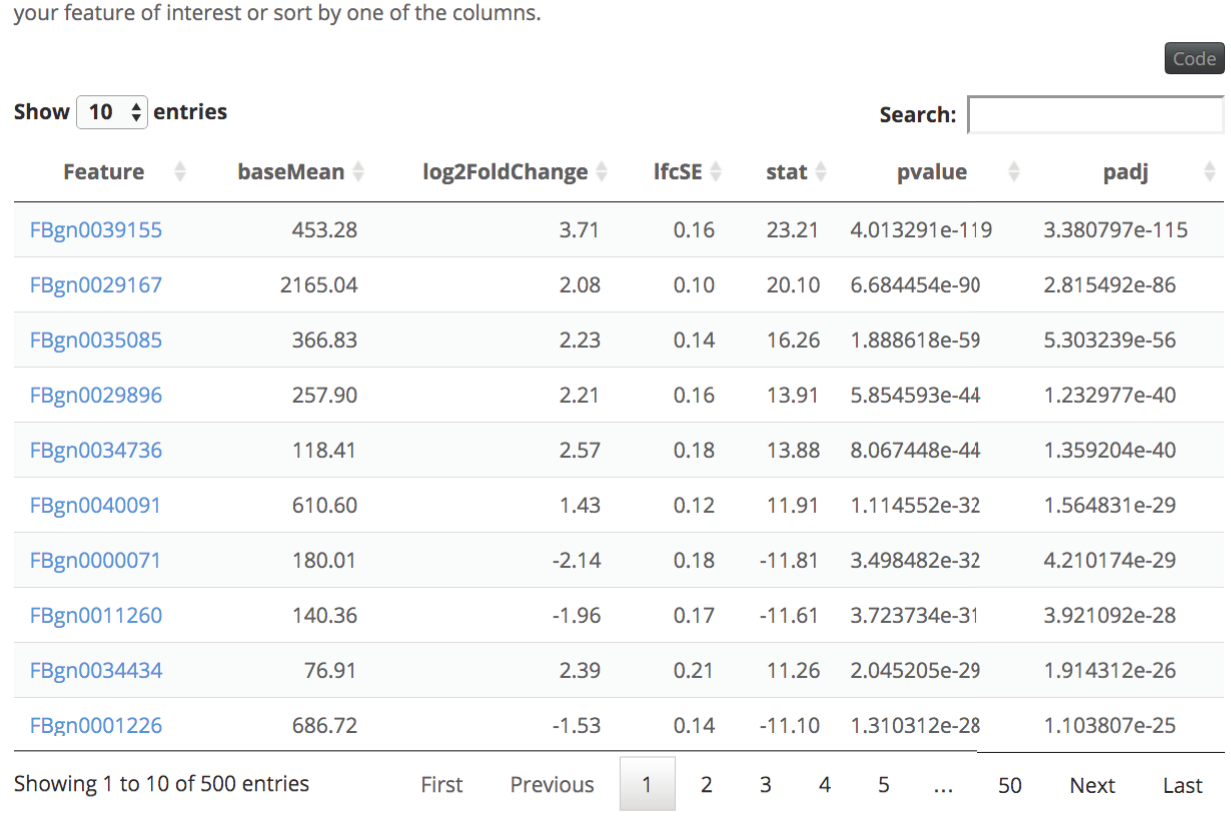
Figure 8. Interactive table for top features from the DESeq2 use case